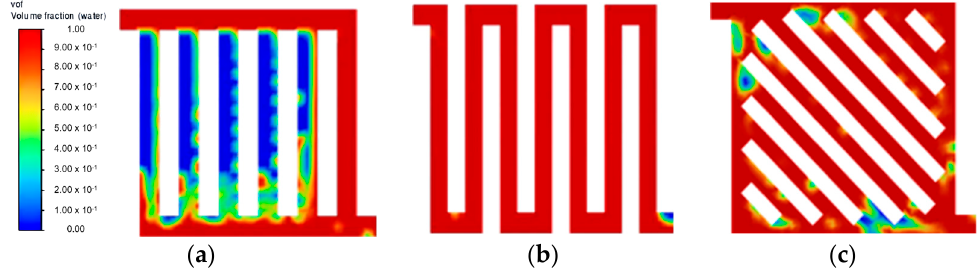
Figure 2. Steady state flow distribution at velocity = 0.50 m ⋅ s − 1 : ( a ) parallel; ( b ) serpentine; and ( c ) symmetry.